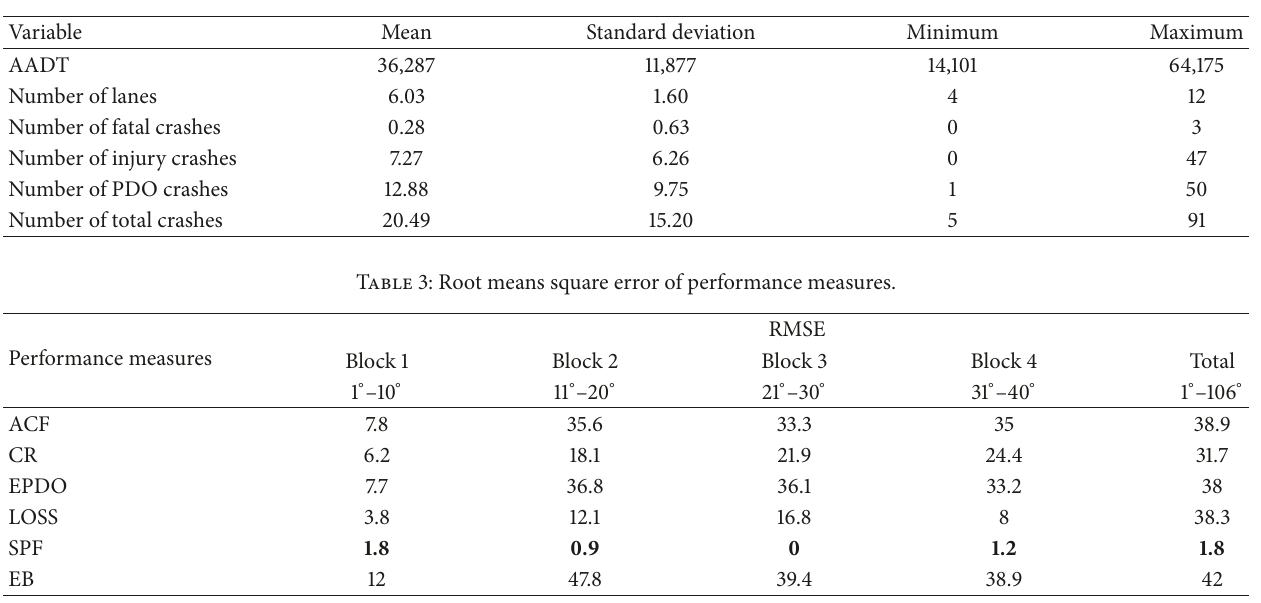
Table 2: Descriptive statistics of variables.